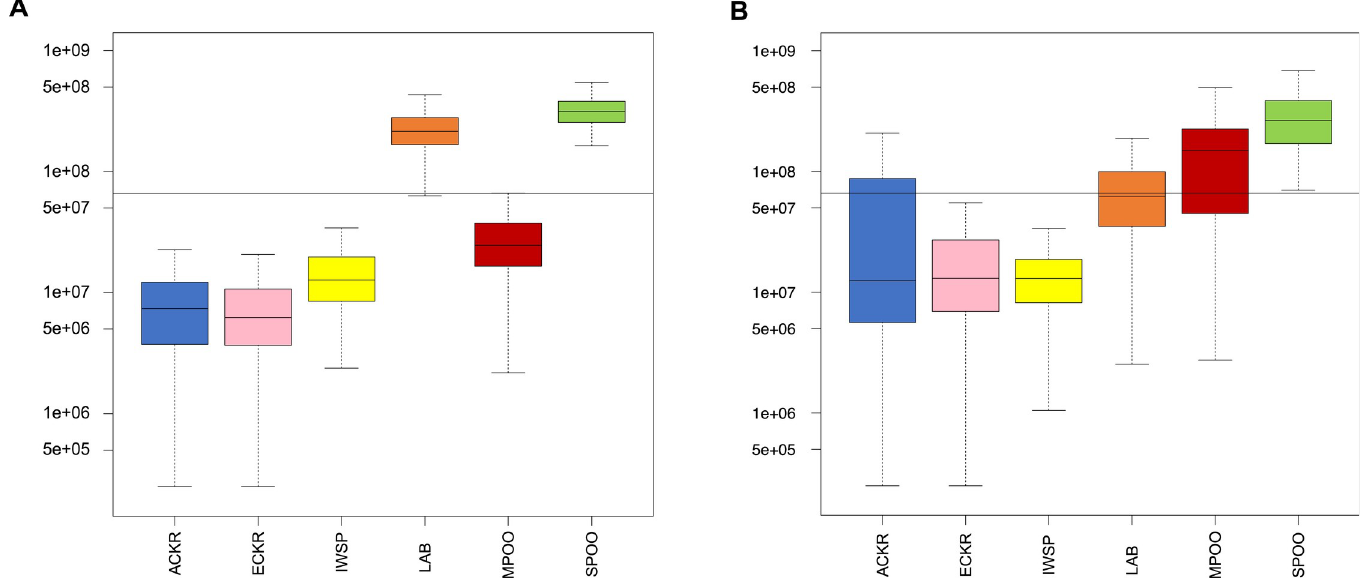
Fig 4. Haplotype sharing analyses of six dog breeds, including the LBD and ALBD. Haplotype sharing boxplot for LBD (A) and ALBD (B), and six component breeds established using a window size of 1,400 SNPs and an overlap of 50 SNPs. The colors of six breeds correspond to the Fig 1. Y-axis indicates total haplotype sharing. Pairs which did not share a haplotype were set at 250,000 bp for